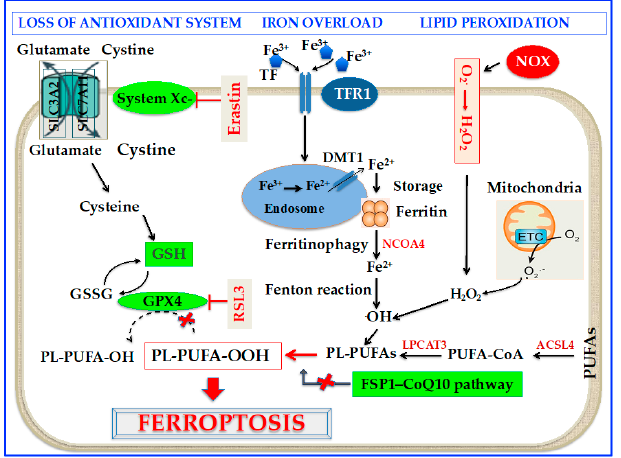
Figure 1. Schematic molecular mechanisms of ferroptosis. Loss of antioxidant system : System Xc- facilitates the cellular uptake of cystine, which is reduced by cystine reductase to cysteine, a key precursor in GSH synthesis. GSH serves as an important reducing cofactor for GPX4 (which catalyzes the reduction in lipid peroxides to their corresponding alcohols) while also forming GSSG. Erastin inhibits the cellular uptake of cystine, thus impairing intracellular GSH synthesis. Depletion of GSH leads to the indirect inactivation of GPX4, and the resulting accumulation of lipid peroxides disrupts membrane integrity ultimately leading to ferroptosis. RSL3 acts by directly inactivating GPX4 and does not interfere with the cellular uptake of cystine or intracellular GSH synthesis. Intracellular iron accumulation : Circulating iron [Fe 3+ ] bound to TF enters into cells by TFR1, localizes in endosomes where it is deoxidized to Fe 2+ . Ultimately, Fe 2+ is released into a labile iron pool in the cytoplasm by DMT1, while excess iron is stored in ferritin. Under certain circumstances, there may be degradation of ferritin through autophagy, which is termed as “ferritinophagy”, a phenomenon that triggers an increase in labile iron pool and OH via the Fenton reaction. This process requires H 2 O 2 production by activation of NOX or mitochondria ETC pathways. Lipid peroxidation : The generation of PL-PUFAs by ACSL4 and LPCAT3 have a main role in promoting lipid peroxidation. At the final step of ferroptosis, lipid peroxidation directly or indirectly induces pore formation of cell membrane, thus triggering cell death. Abbreviations: ACSL4: Acyl-Coenzyme A synthetase long-chain family member 4; CoQ10: coenzyme Q10 oxidoreductase; DMT1: divalent metal transporter 1; ETC: electron transport chain; FSP1: ferroptosis inhibitor 1; GPX4: glutathione peroxidase 4; GSH: reduced glutathione; GSSG: oxidized glutathione; H 2 O 2 : hydrogen peroxide; LPCAT3: lysophosphatidylcholine acyltransferase 3; NCOA4: nuclear receptor coactivator 4; NOX: nicotinamide adenine dinucleotide phosphate oxidase; O 2 - : superoxide; ·OH: hydroxyl radical; PL- PUFA-OH: phospholipid polyunsaturated fatty acid alcohols; PL-PUFA-OOH: phospholipid polyunsaturated fatty acid peroxides; PUFA-CoA: polyunsaturated fatty acid coenzyme A; RSL3: RAS-selective lethal 3; TF: transferrin; TFR1: transferrin receptor 1. Modified from Fratta Pasini et al. [22]